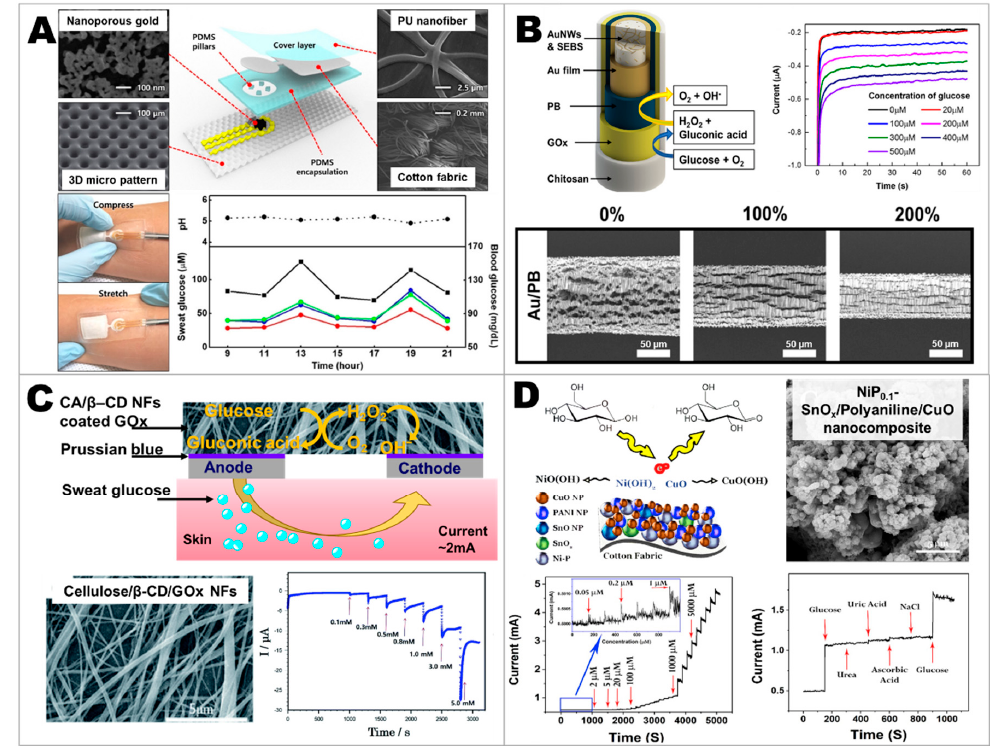
Figure 3. Examples of glucose sensors. ( A ) Wearable stretchable capillary microfluidic non-enzymatic glucose sensors. Adapted with permission from [85], copyright 2019, American Chemical Society. ( B ) Wearable fiber-based enzymatic glucose sensors. Adapted with permission from [86], copyright 2019, American Chemical Society. ( C ) Wearable cellulose / β -cyclodextrin nanofiber enzymatic glucose sensors. Adapted under the terms and conditions of the CC-BY 3.0 from [61], copyright 2019, Kim et al., published by RSC Adv. ( D ) Wearable and flexible metal-based catalysts / polyaniline / cotton-based non-enzymatic glucose sensors. Adapted with permission from [87], copyright 2019,